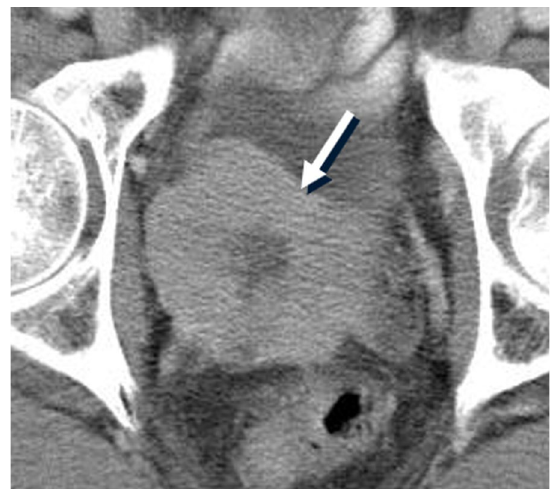
thickening of the bladder